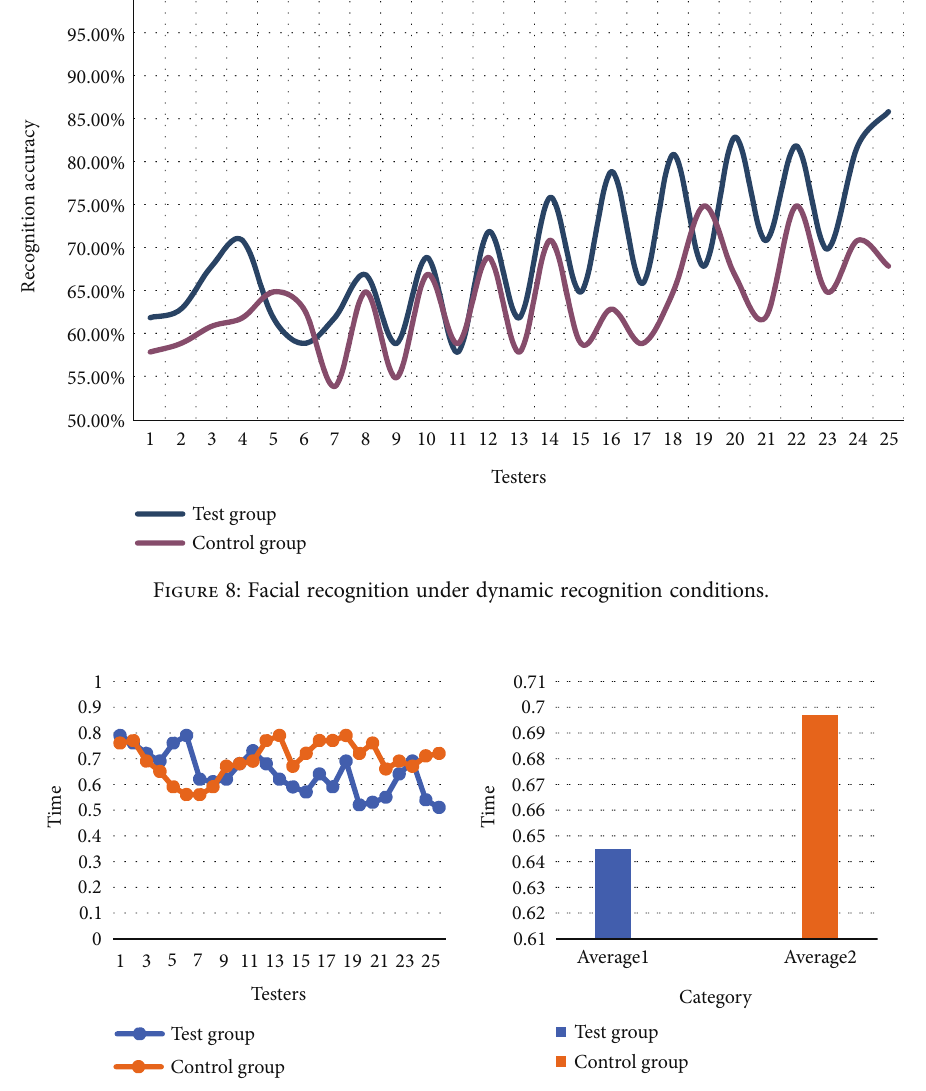
Figure 9: Facial recognition